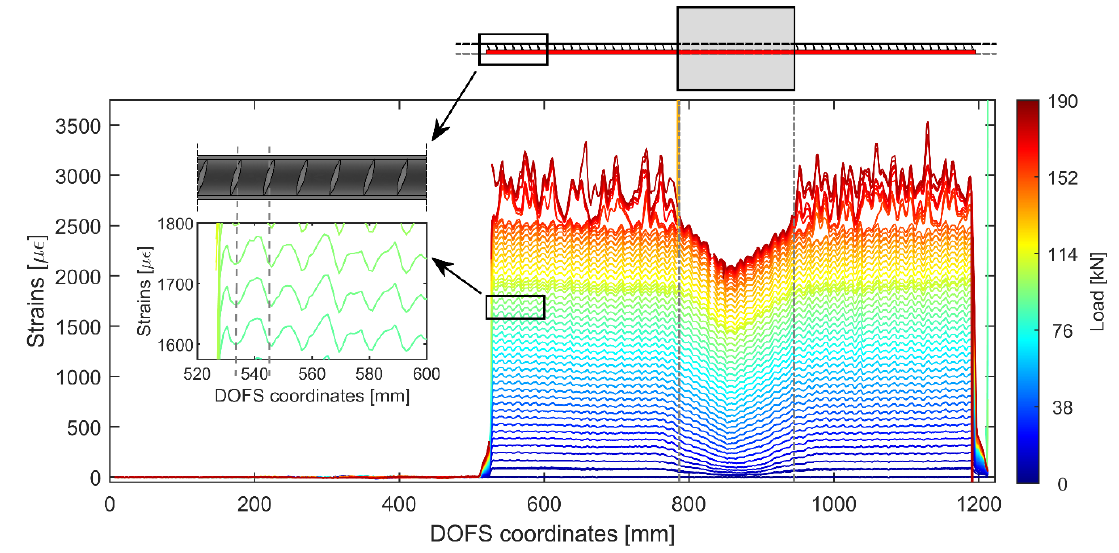
Figure 11. Strain profiles of a 15D20_21 RC tie test with the DOFS bonded with a combination of groove, CYN and SI.